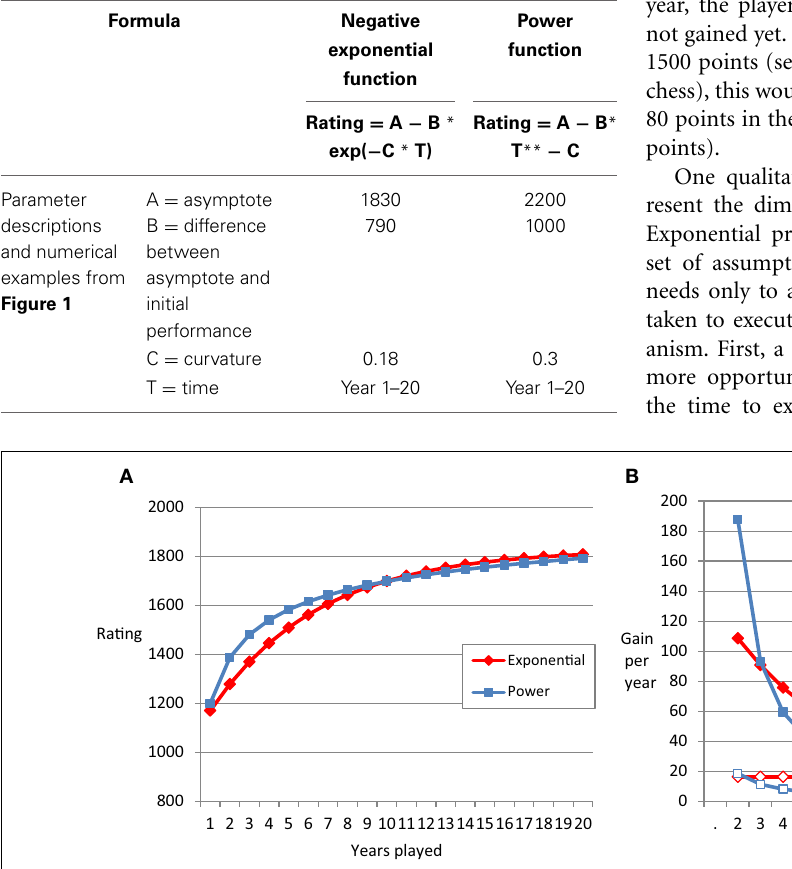
Table 1 | Formulas of negative exponential and power function and the example parameters used for Figure 1.